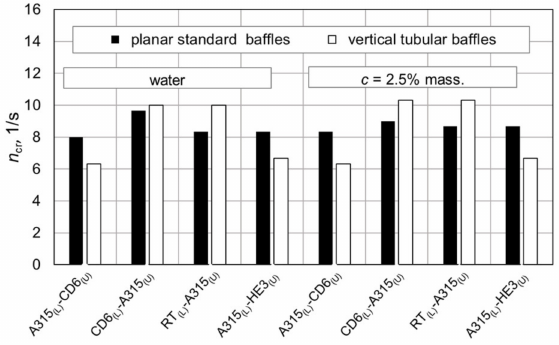
Figure 10. Dependence of n cr = f(configurations of impeller); w og = 3.413 × 10 − 3